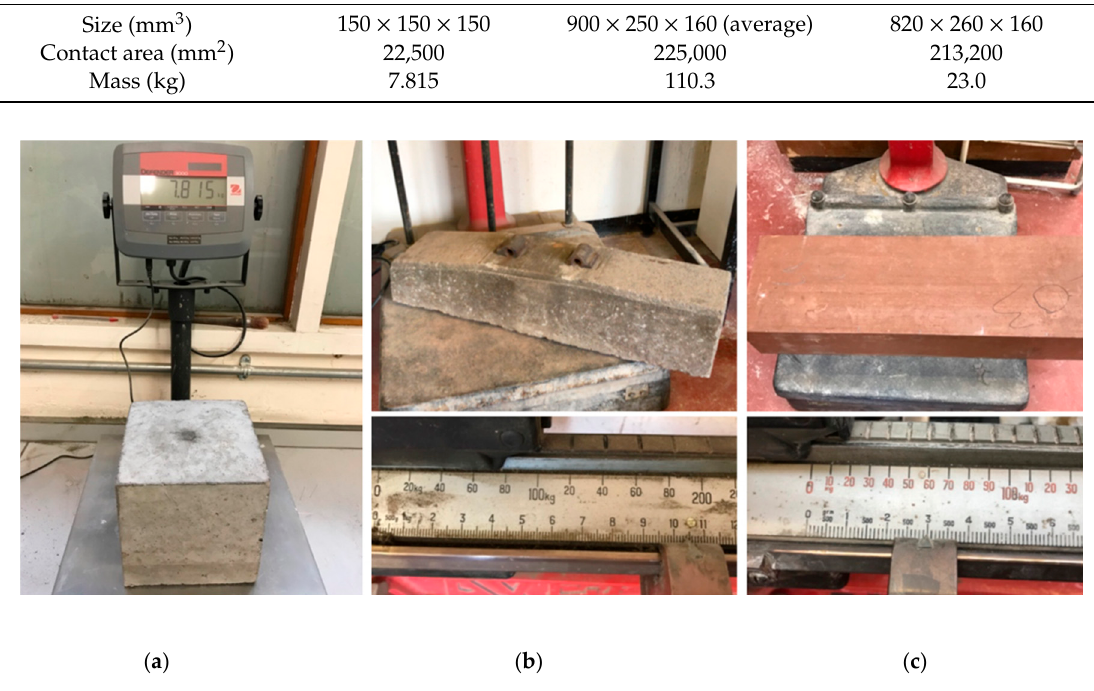
Figure 3. ( a ) Concrete block ( b ) concrete sleeper ( c ) FFU sleeper.